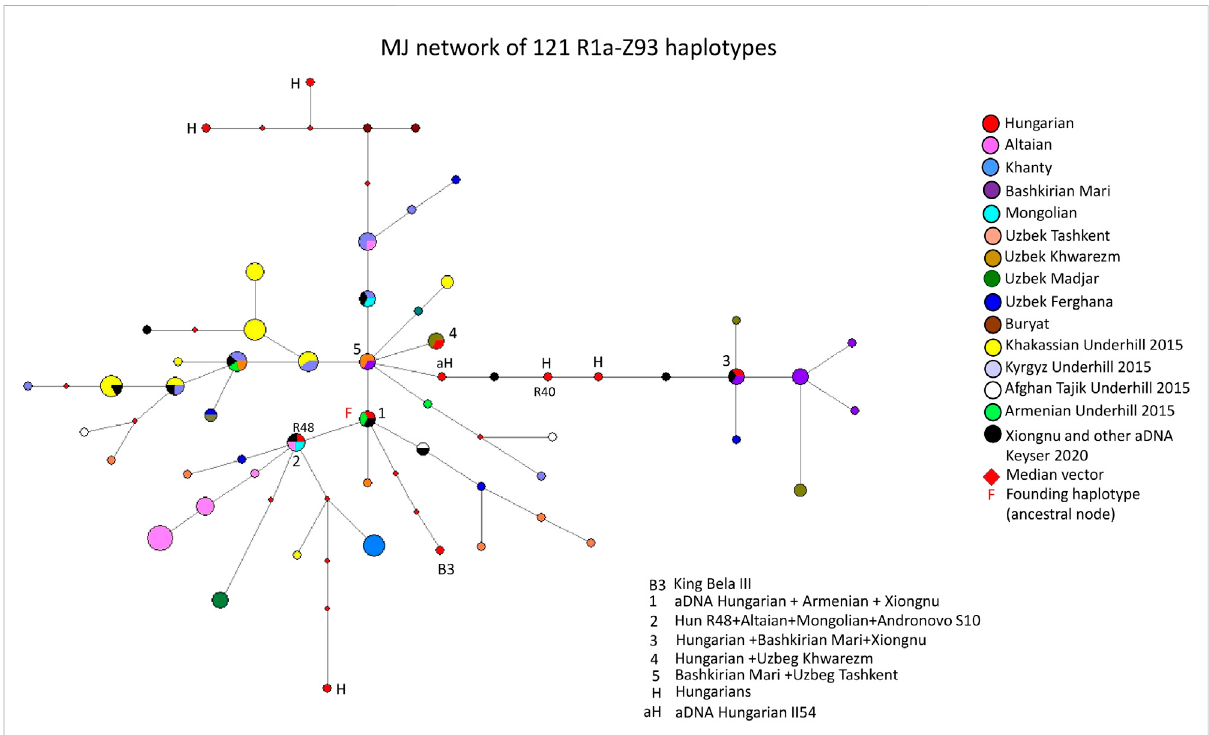
FIGURE 2 TheMedian-JoiningNetworks(MJ)of121R1a-Z93haplotypes.Thecirclesizesareproportionaltothehaplotypefrequencies.Thesmallestarea is equivalent to one